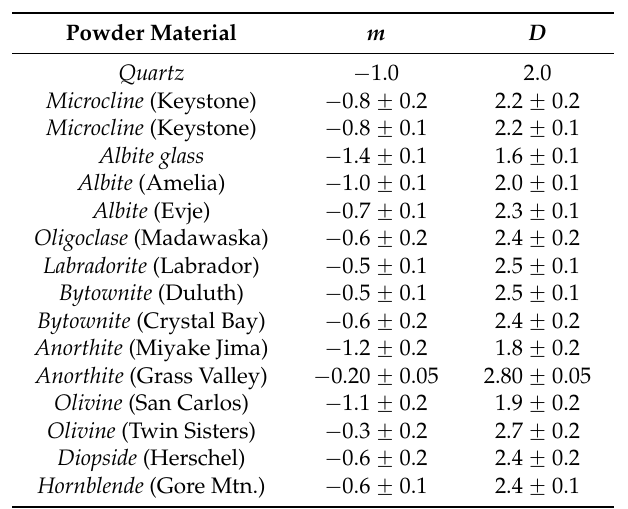
Table 2. Evaluation of fractal dimensions of natural mineral powders—table transferred from [26]. The values of the fractal dimension D were computed on the basis of the above derived relation D = m + 3, see Equation